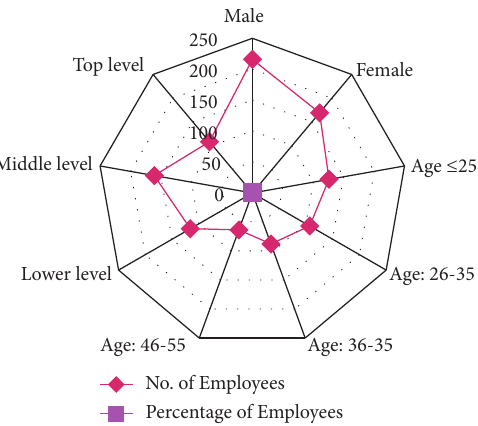
Figure 2: Demographic profile of